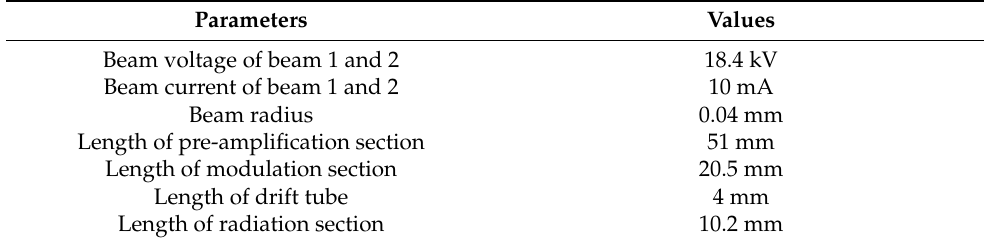
Table 4. Parameters of the PA-HHTWT.